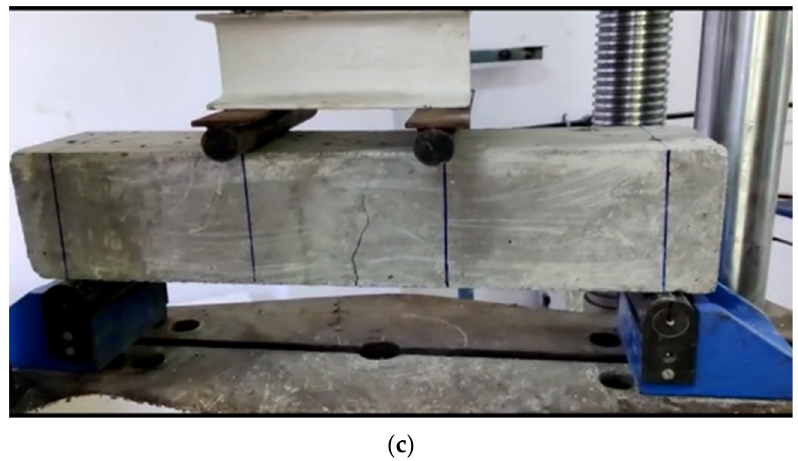
Figure 7. Testing of specimens. ( a ) Compressive strength test. ( b ) Tensile strength test. ( c ) Flexural strength test.